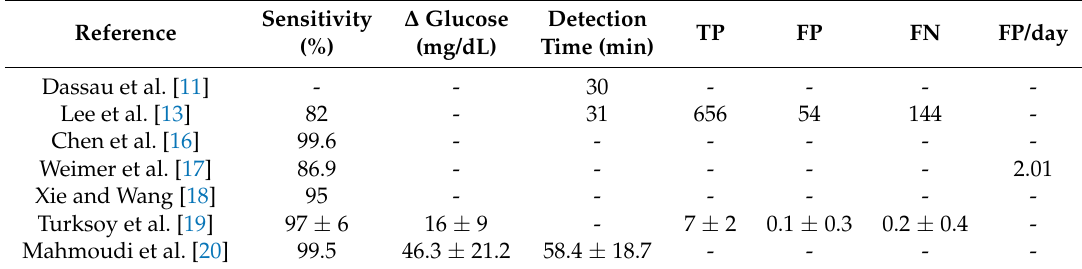
Table 6. Population performance metrics of meal detection algorithm in other